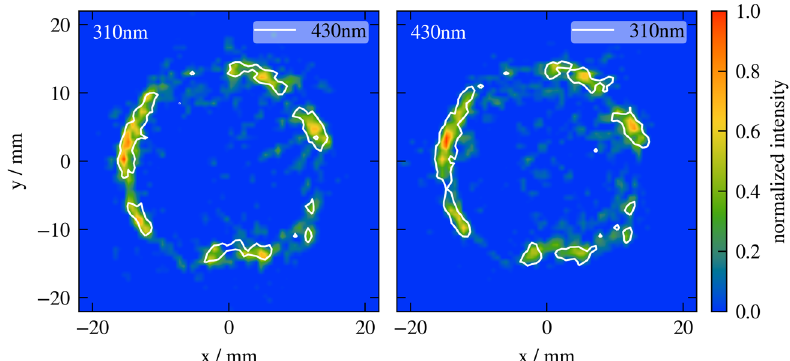
Figure 12. Simultaneously acquired, normalized species distributions of OH* (310 nm, left) and CH* (430 nm, right) measured in a non-sooting turbulent methane / air di ff usion flame at h = 13.3 mm above the burner with an exposure time of 1 ms ( λ 1 = 5, λ 2 = 5, CH 4 2 slm, air 100 slm). The white solid lines are the 25% isolines of the other wavelengths / species, respectively.